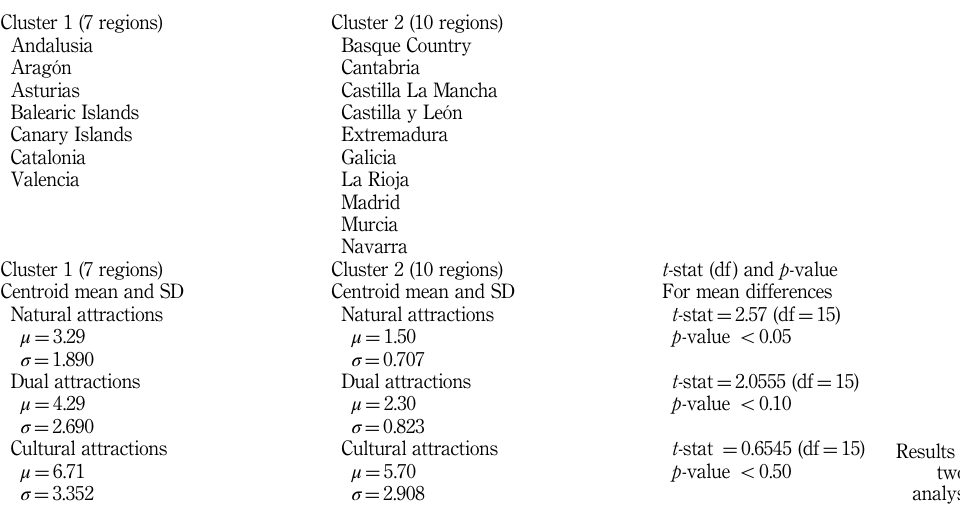
Table III. Results based on the two-step cluster analysis